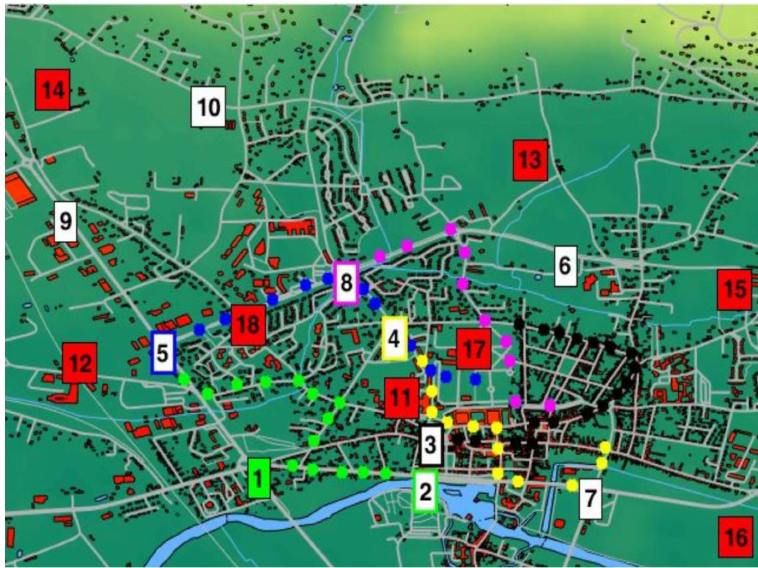
Figure 6. Map for nodes geolocation with their’s moving paths for the prepared scenario 1.